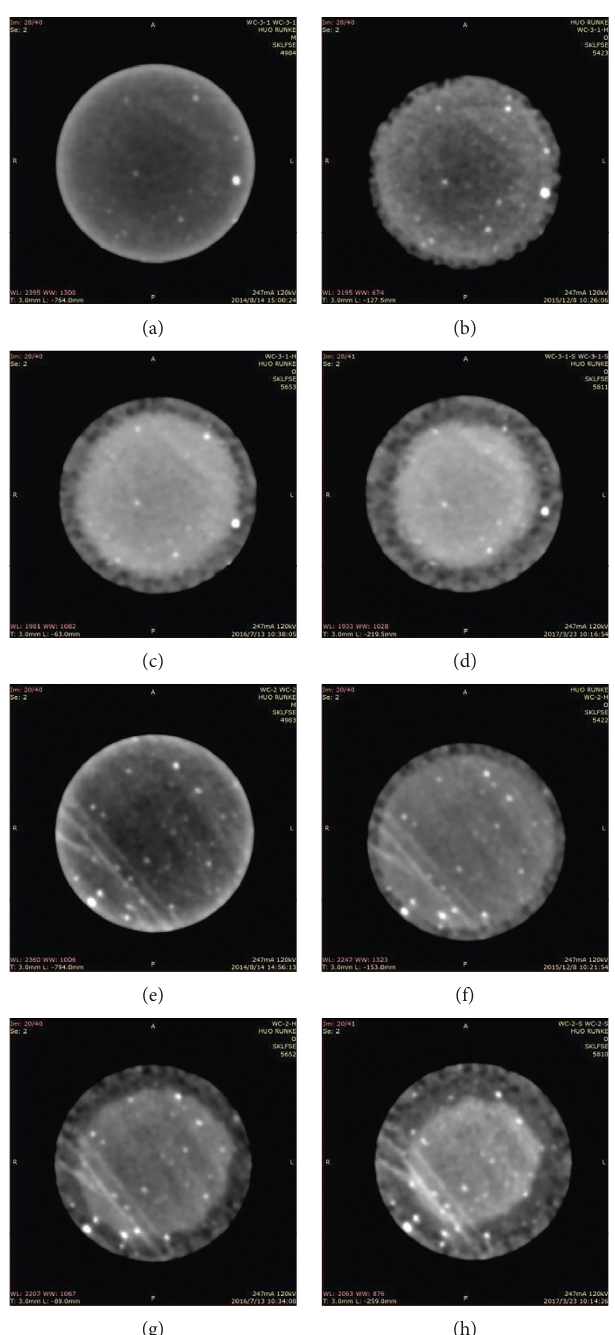
Figure 13: CTimages of the middle layer of the sandstone specimens subjected to sulfuric acid solution with different pH values for different stages. (a) pH � 3 H 2 SO 4 (0 day), (b) pH � 3 H 2 SO 4 (30 days), (c) pH � 3 H 2 SO 4 (90 days), (d) pH � 3 H 2 SO 4 (180 days), (e) pH � 1 H 2 SO 4 (0 day), (f) pH � 1 H 2 SO 4 (30 days), (g) pH � 1 H 2 SO 4 (90 days), and (h) pH � 1 H 2 SO 4 (180